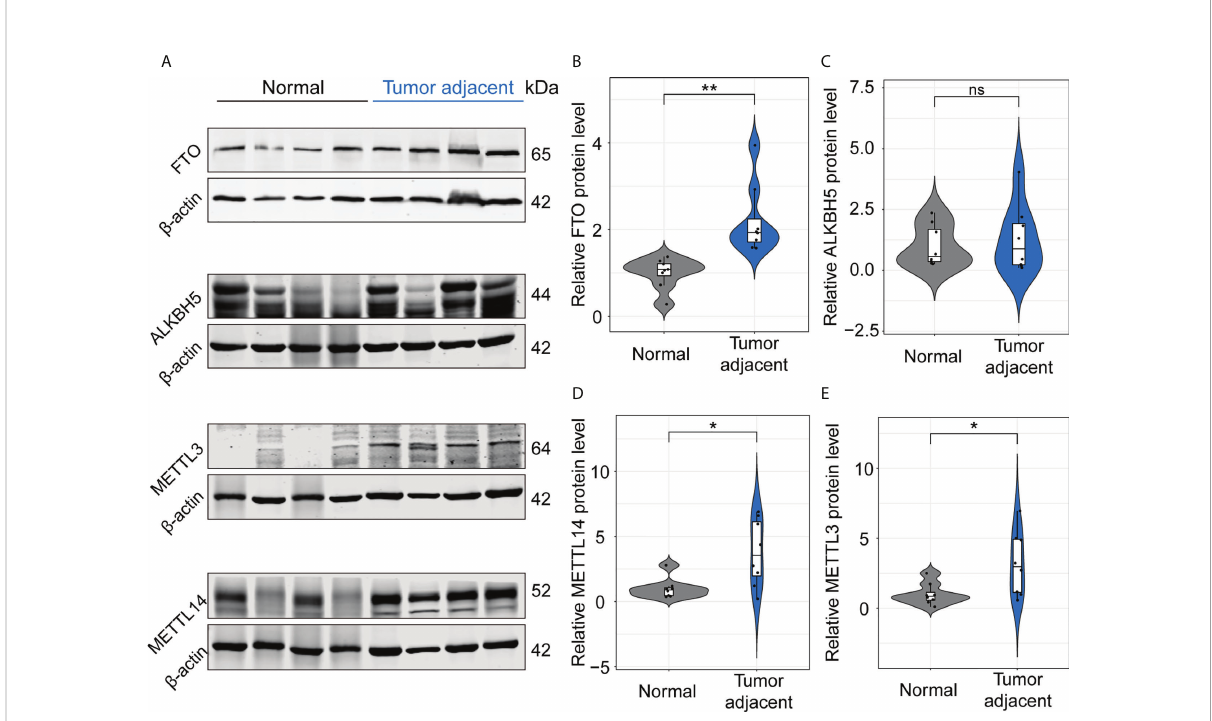
FIGURE 2 FTO functions as a main modulator for the decrease of m6A mRNA methylation of IL-17RA. (A) Western blot for the expression of FTO, ALKBH5, METTL3, and METTL14 in normal liver and tumor-adjacent liver tissues of patients. (B-E) Quanti fi cations of FTO, ALKBH5, METTL14, and METTL3 expression in different tissues by Western blot. All experiments were repeated at least three times and expressed as the means ± SEM. ns, not signi fi cant; * p < 0.05; ** p <